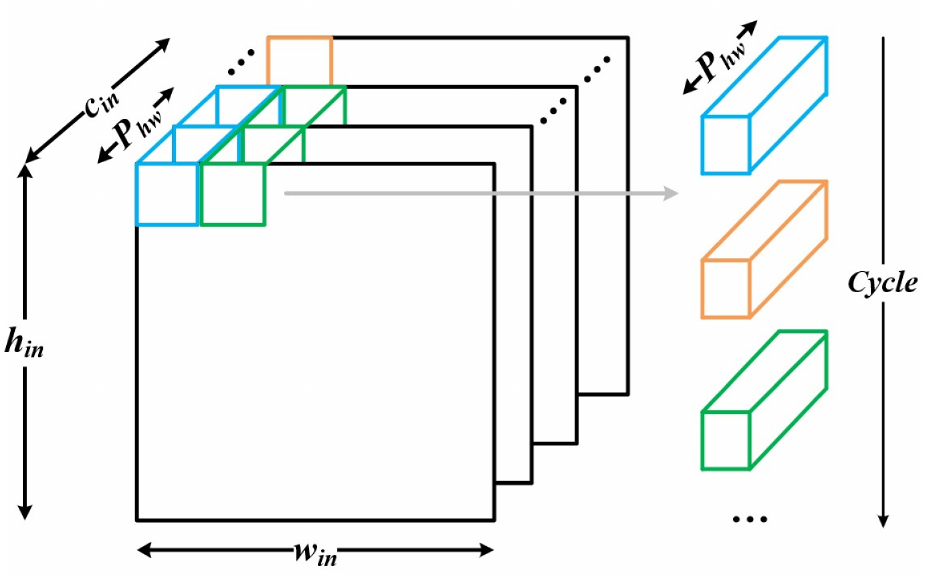
Figure 4. Data scheduling example of the second parallelism scheme.